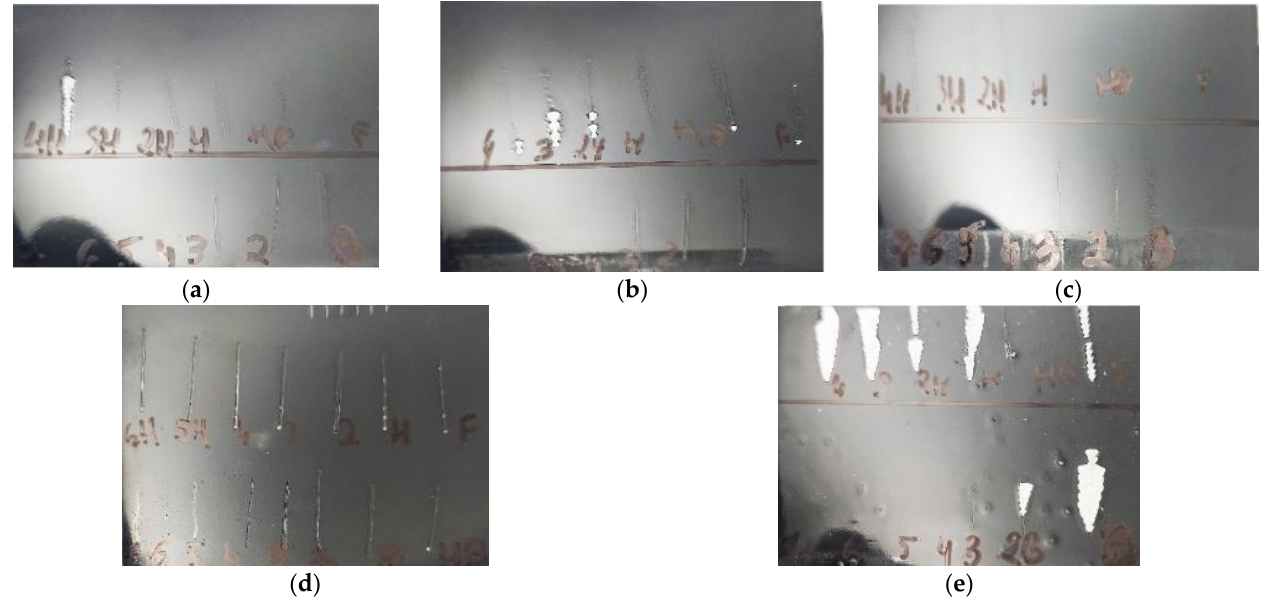
Figure 5. Results of lacquer adhesion tests using the cross-cut method; ( a ) series 1, ( b ) series 2, ( c ) series 3, ( d ) series 4 and ( e ) series 5.